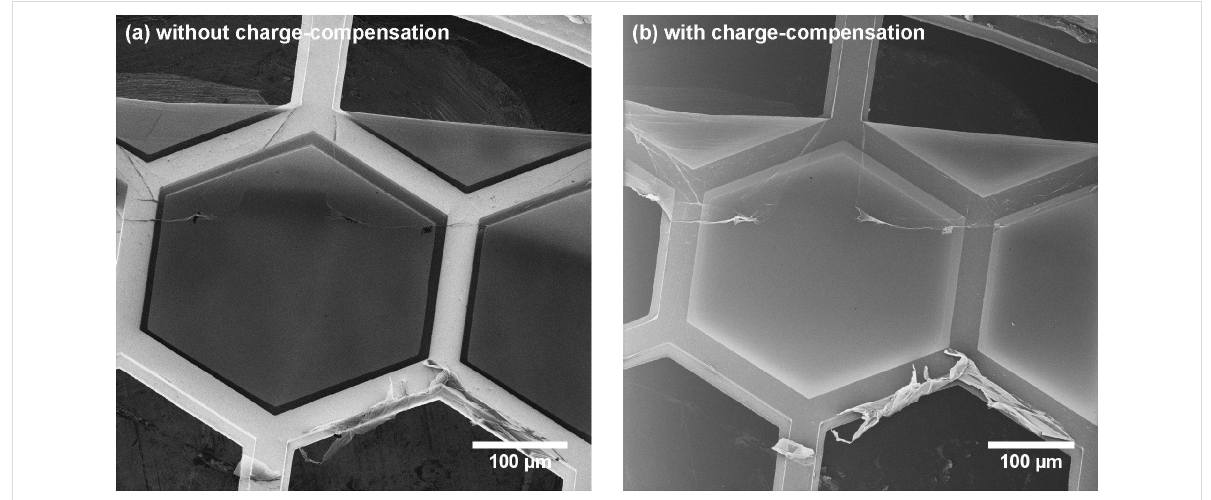
Figure 6: The same CNM is imaged (a) without and (b) with charge compensation. Detailed information on all HIM images is given in Supporting Information File 1, Tables S1 and S2.